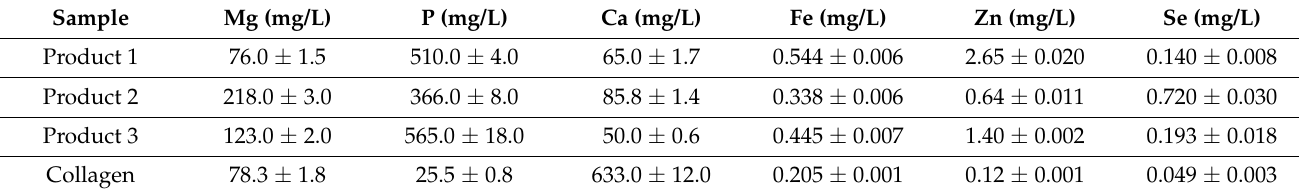
Table 1. Mineral content before simulated gastrointestinal digestion of product 1, product 2, product 3 and collagen.